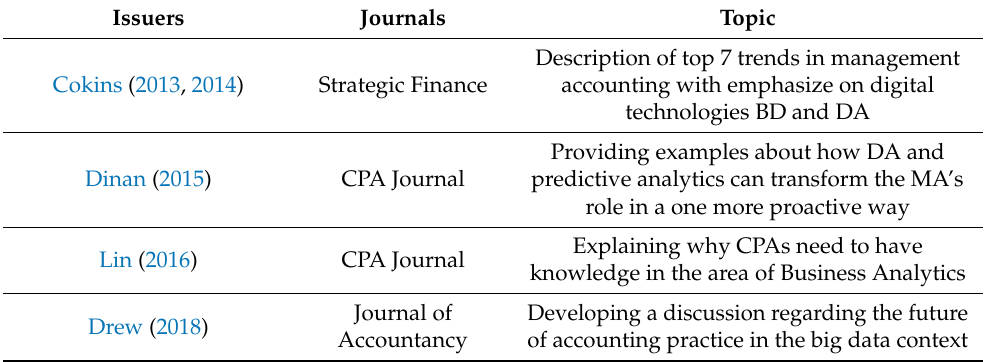
Table 2. Articles in professional